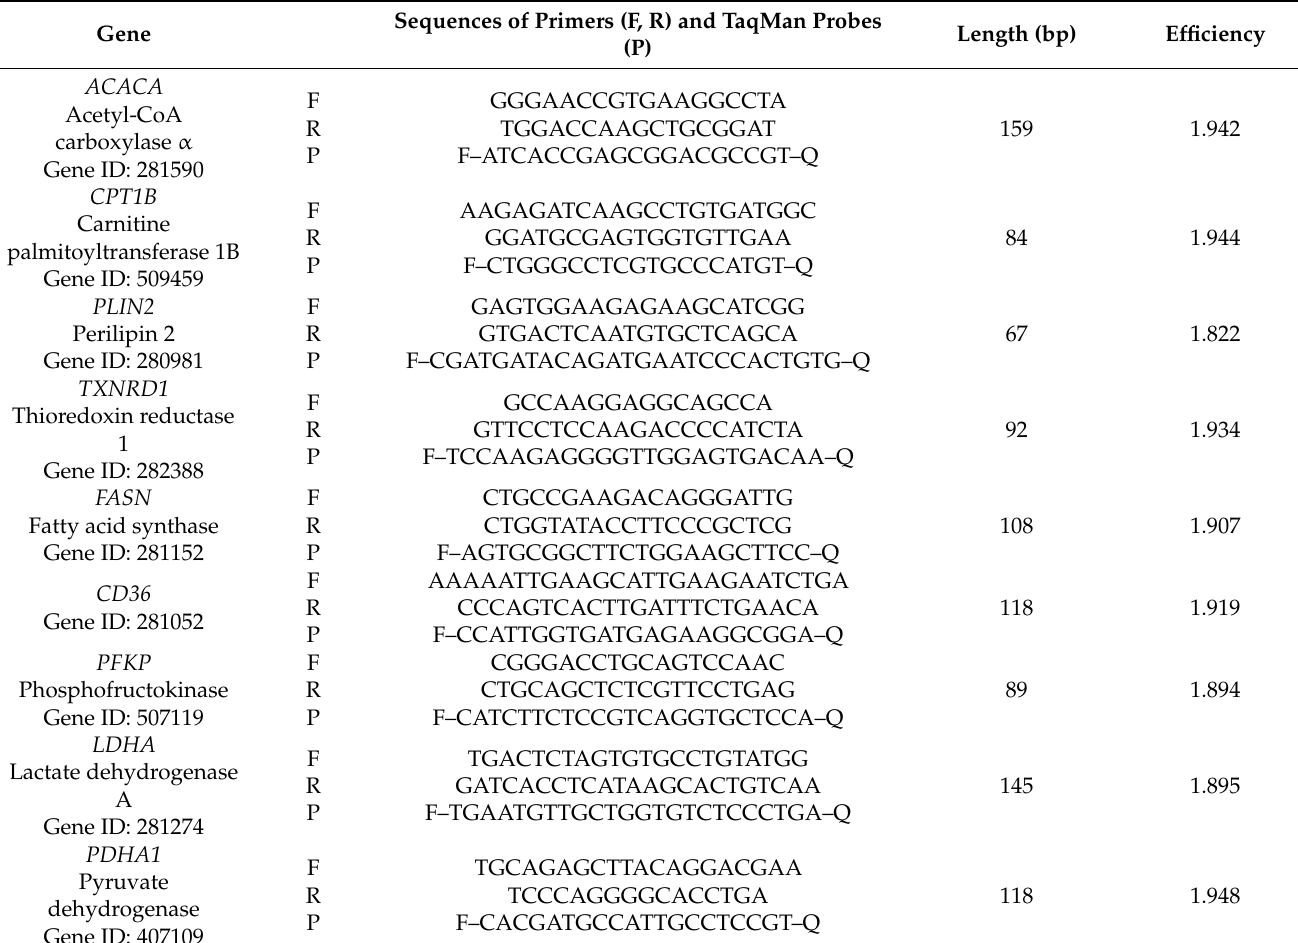
Table 1. The sequences of primers and probes, their efficiency, and the length of the products obtained from mRNA gene expression experiment. Selected genes were analyzed in cumulus cells. F – forward primer sequence, R – reverse primer sequence, P – probe sequence. Sequences of Primers (F, R) and TaqMan Probes Gene Length (bp) (P)